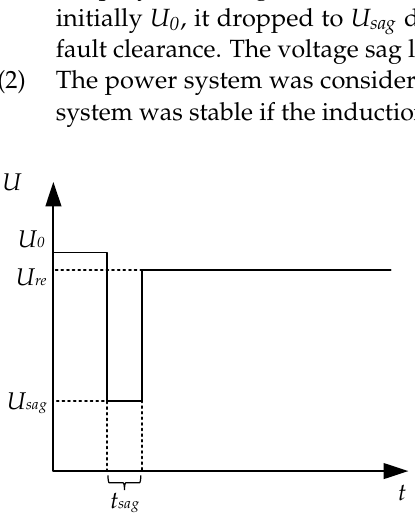
Figure 2. Simplified voltage sag waveform.